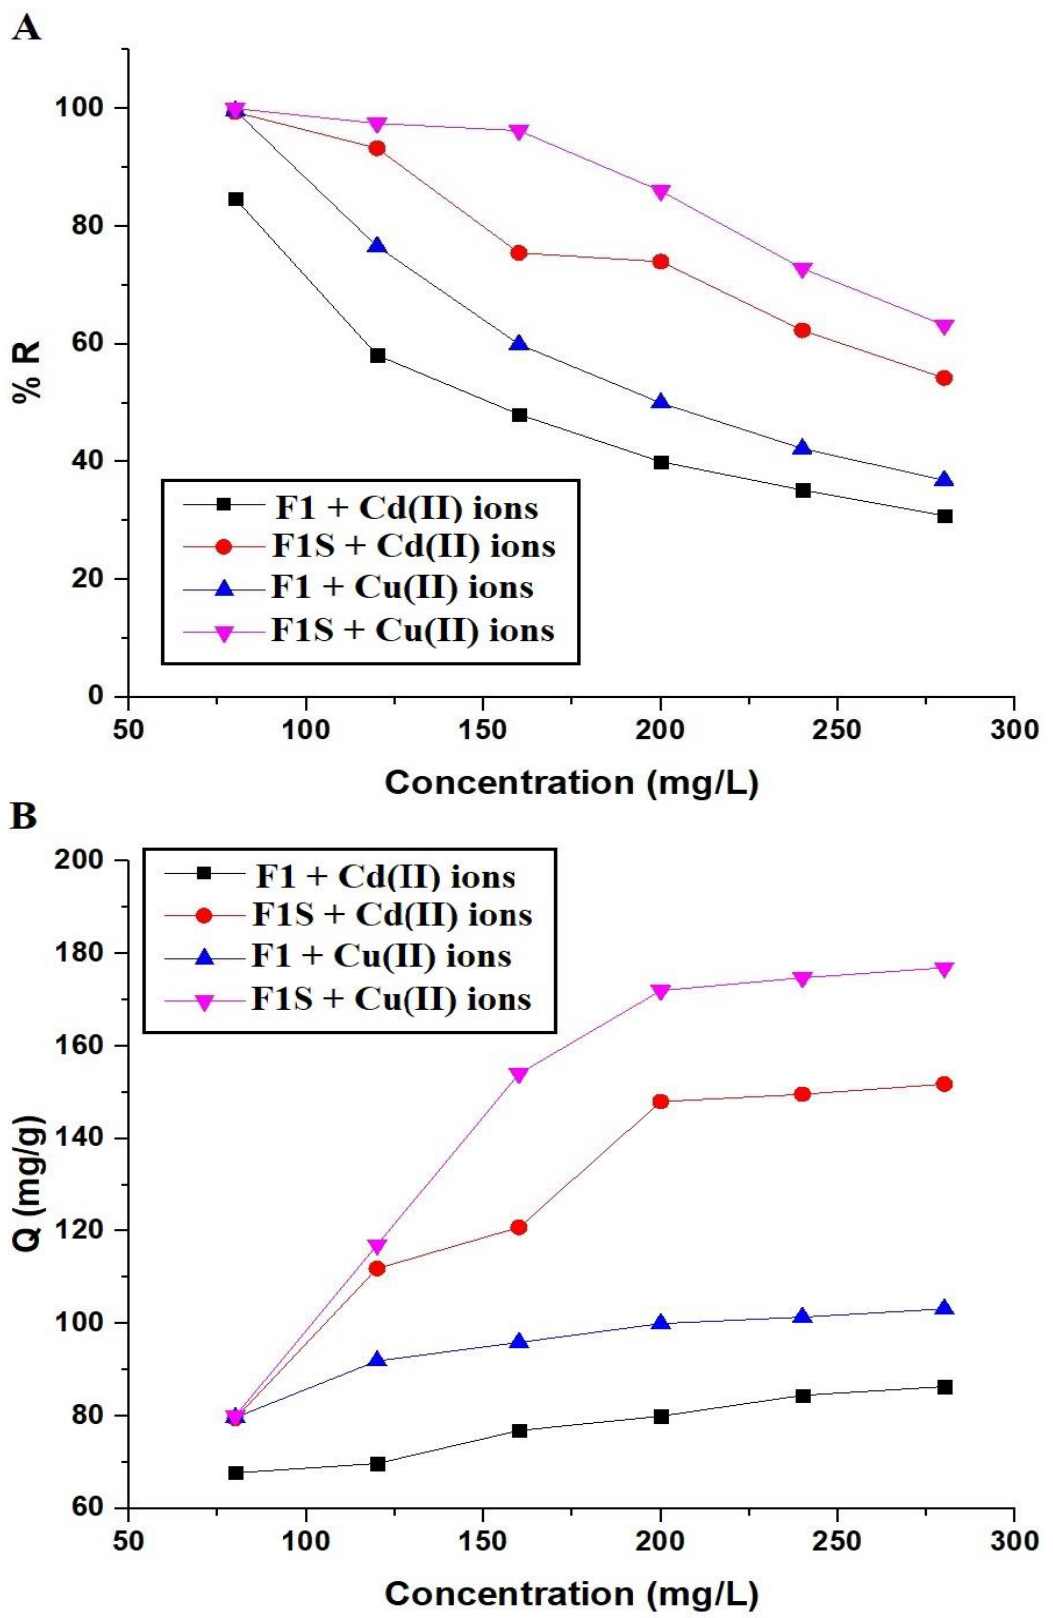
Figure 11. The effect of initial concentration of copper and cadmium ions on the % removal ( A ) and the adsorption capacity of the F1 and F1S samples ( B ). Experimental conditions: volume = 40 mL, pH = 7.5, temperature= 298 K, amount of adsorbent = 0.04 g, and time = 80 min.